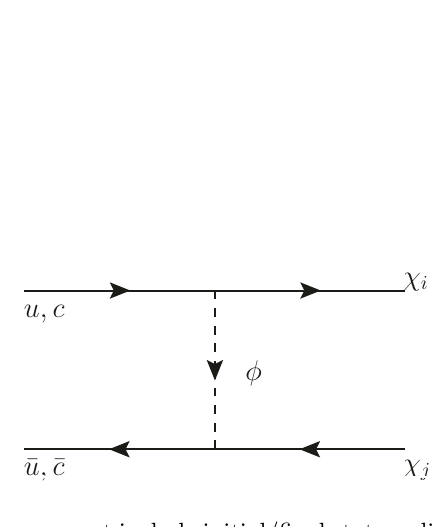
Figure 19 . The above diagram must include initial/(cid:12)nal state radiation from external legs or inter- nal bremsstrahlung from the mediator. The contribution is roughly equal amongst these emissions.